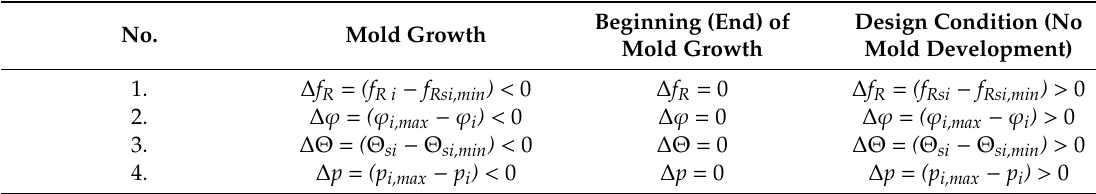
Table 2. Conditions for mold growth on the surface of a building barrier in the form of a parameter di ff erence ( ∆ ). Mold